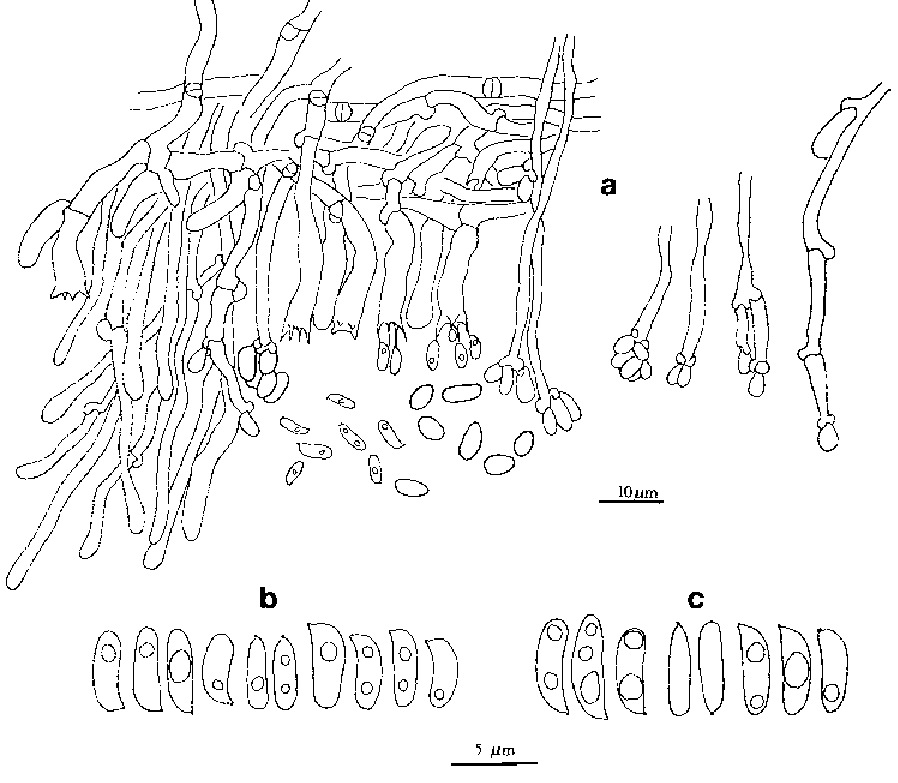
Fig. 1. Syzygospora lapponica Miettinen & Kotir. (a b drawn from Miettinen 10748 , type,